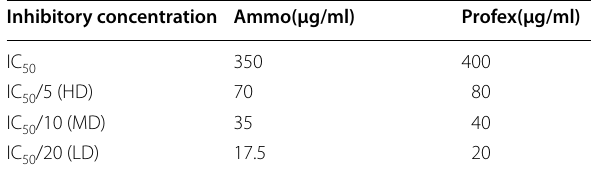
Table 1 IC value and sub-lethal concentrations obtained 50 after 48 h of exposure to Ammo and Profex, where IC Inhibitory Concentration represents high dose (HD), Inhibitory Concentration IC /10 represents medium dose (MD) and 50 Inhibitory Concentration IC /20 represents low dose (LD) 50